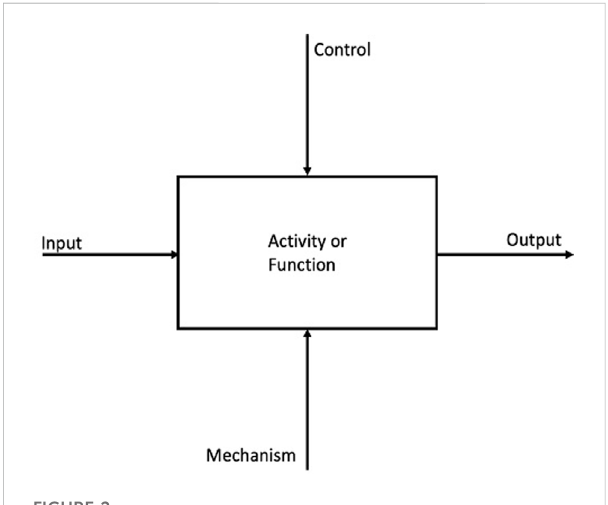
FIGURE 2 The IDEF0 schematic [ adapted from Reslan et al., 2022].